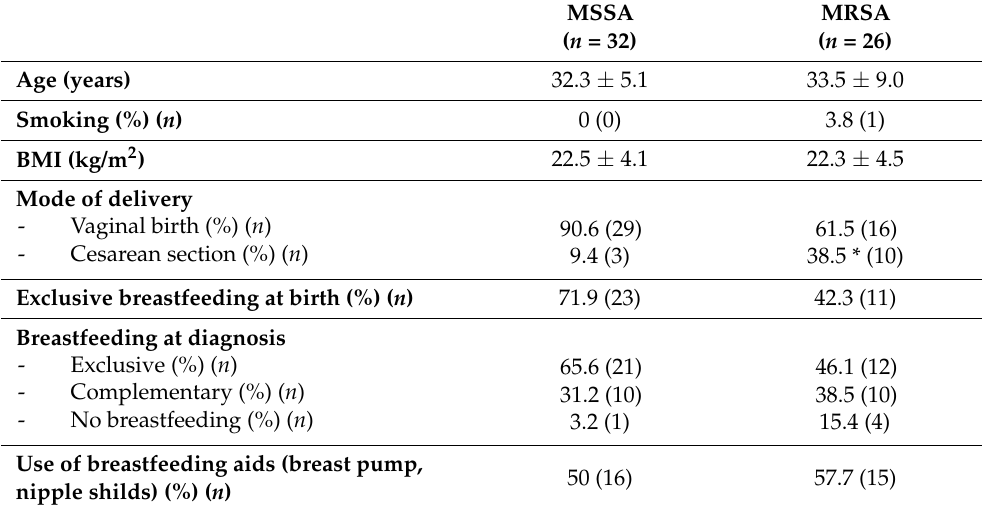
Table 5. Socio-demographic and obstetric features of patients with S. aureus infection.